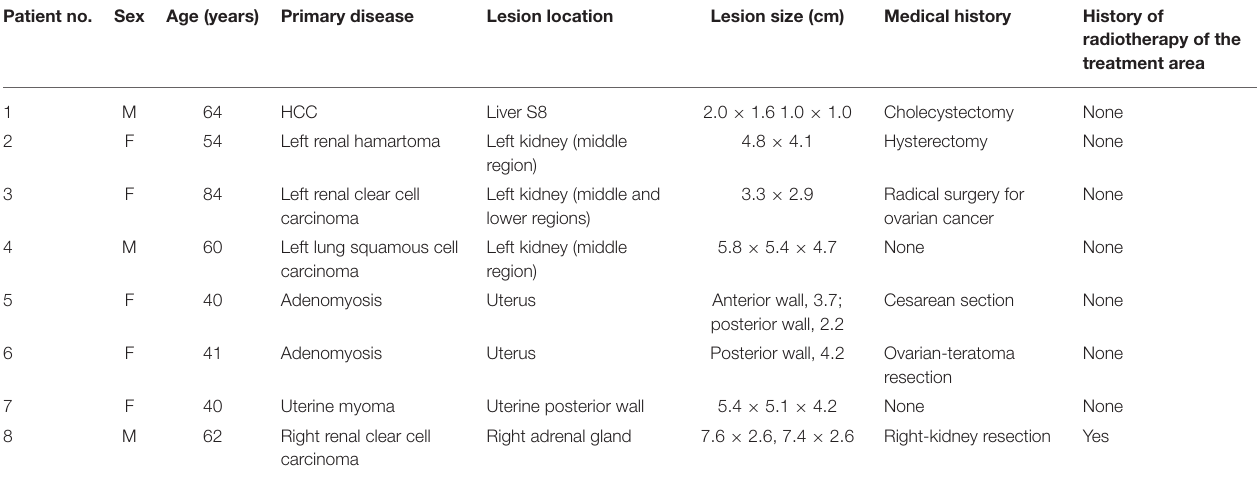
TABLE 1 | Clinical characteristics of patients with an intestinal fistula. Patient no. Sex Age (years) Primary disease